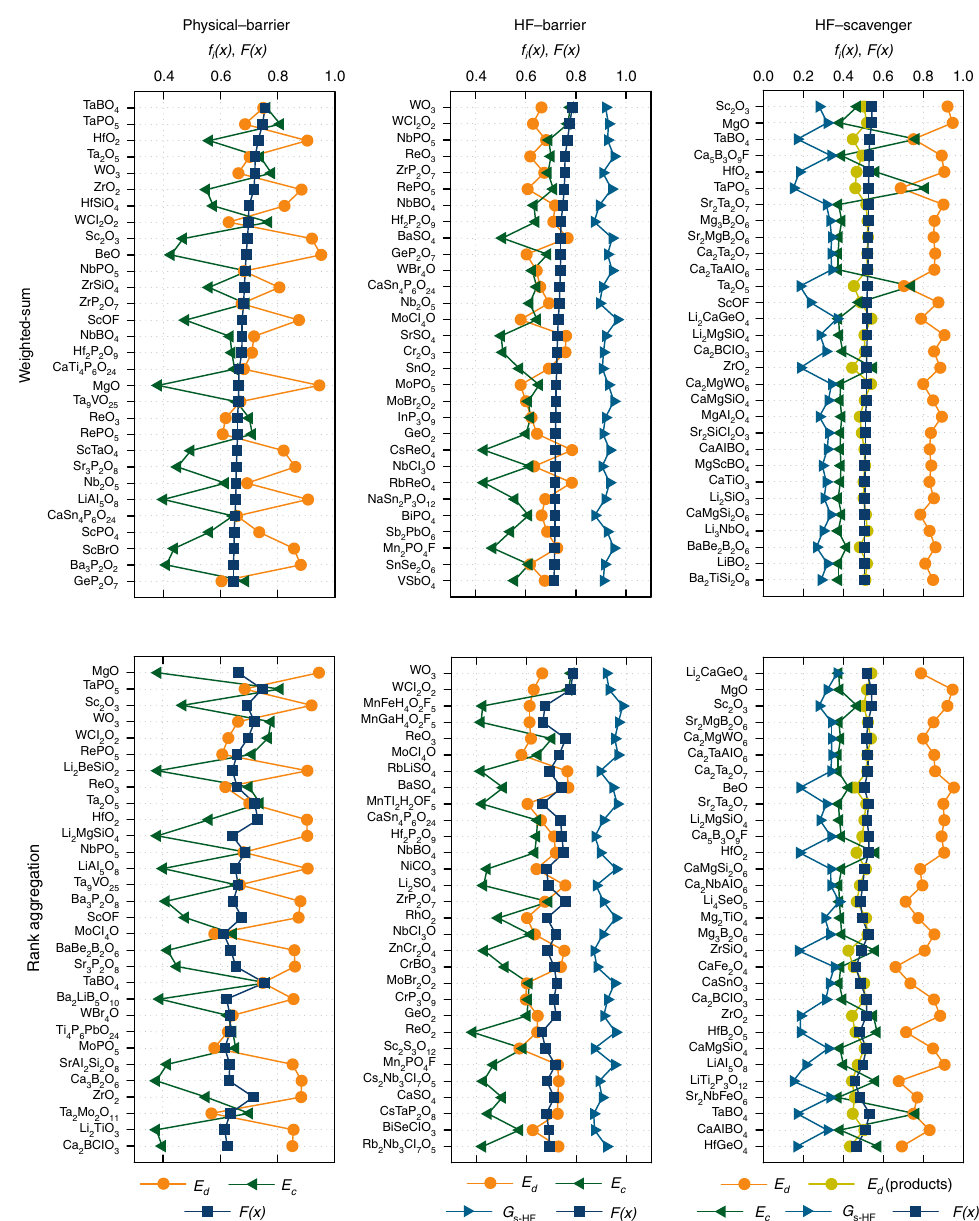
Figure 5 | Material rankings for functional coatings. The rankings for the top 30 candidates obtained with weighted-sum and rank aggregation methods for physical barrier, HF-barrier and HF-scavenger coatings are shown. Individual attributes, f i ( x ) and the resulting global objective F ( x ) are given for each material. Individual attributes and global objectives are also given in the rank aggregation panels, to allow comparisons between each method. The highest- rank material is on top in each list. Note f ( x ) of G s (cid:2) HF denotes opposite ideal limits for HF-barrier and HF-scavengers as defined in Table Here we select two of the most common cathodes that LiMn 2 O 4 , and search for optimized HF-scavenger coating materials among the B 5,200 thermodynamically stable candi-